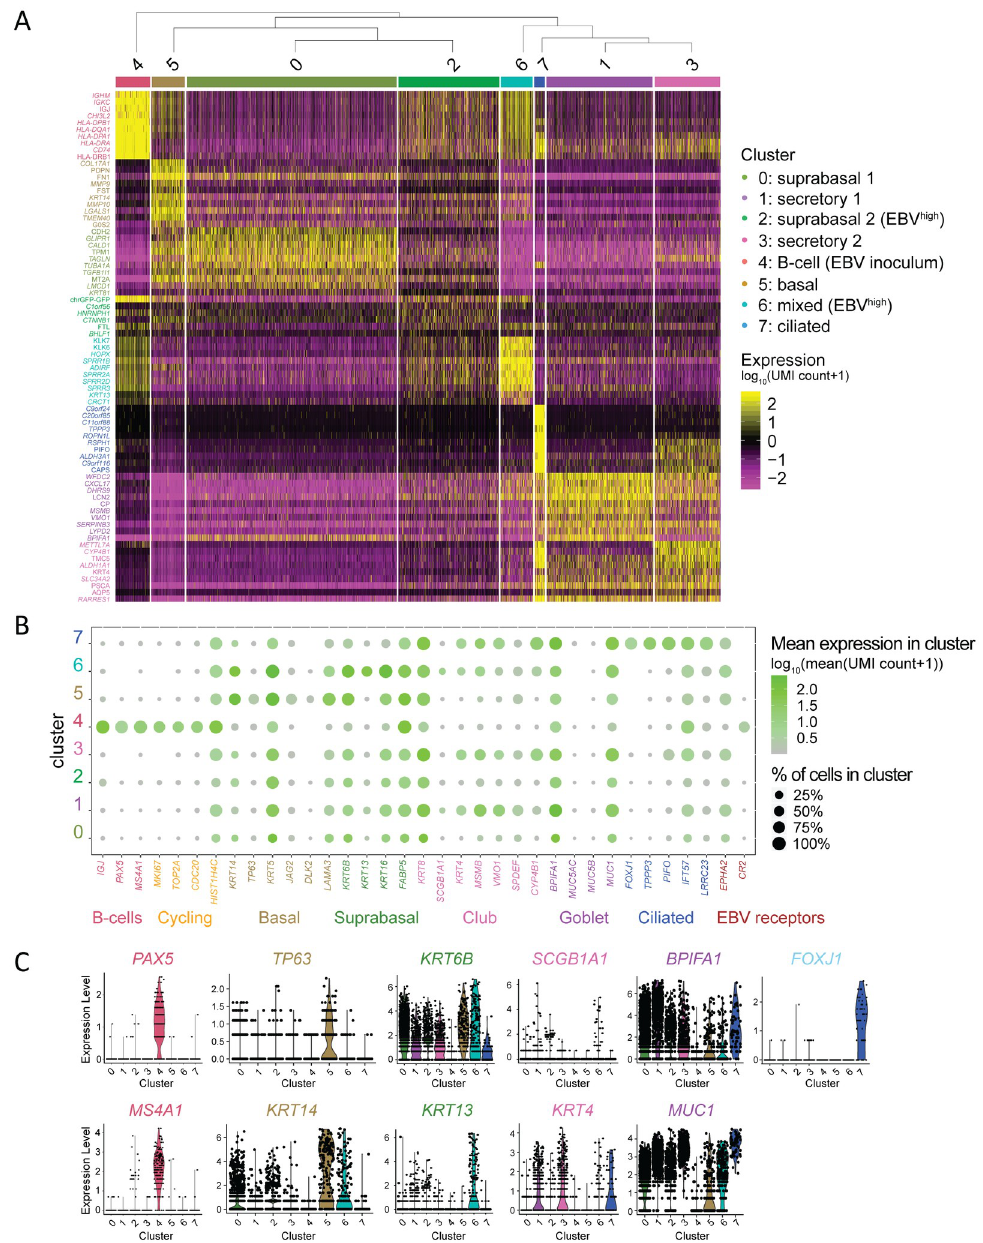
Fig 6. Assignment of cluster identity by cell type-specific marker genes for donor no. 4. (A) Hierarchical clustering of heatmap representing cluster-specific top marker genes. Expression shows log10 transformed pseudocount (UMI count +1). (B) Dot plot representing marker gene expression by cluster. Dot size indicates the percentage of cells in each cluster expressing the marker gene. Color gradient indicates the mean expression of each marker gene, averaged from positively scored cells, for each cluster. Cluster identity enriched for cell-type specific marker genes are color-coded. Cluster 6 expresses a mixture of marker genes indicative of multiple cell types (basal, suprabasal, goblet/mucosecretory). The EBV receptor gene, CR1 , is not shown as it was not expressed according to the count matrix. (C) A few of the highly cell type- specific marker genes were chosen for display by violin plots.